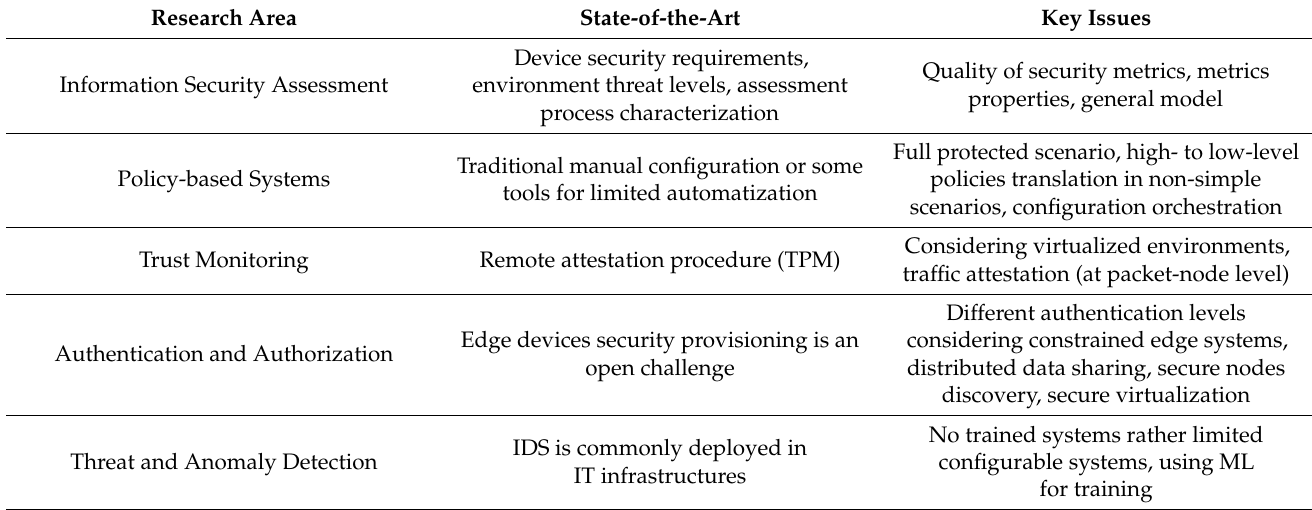
Table 1. Relevant research areas for IoT complex supply chains including current advances and key issues. Research Area Key